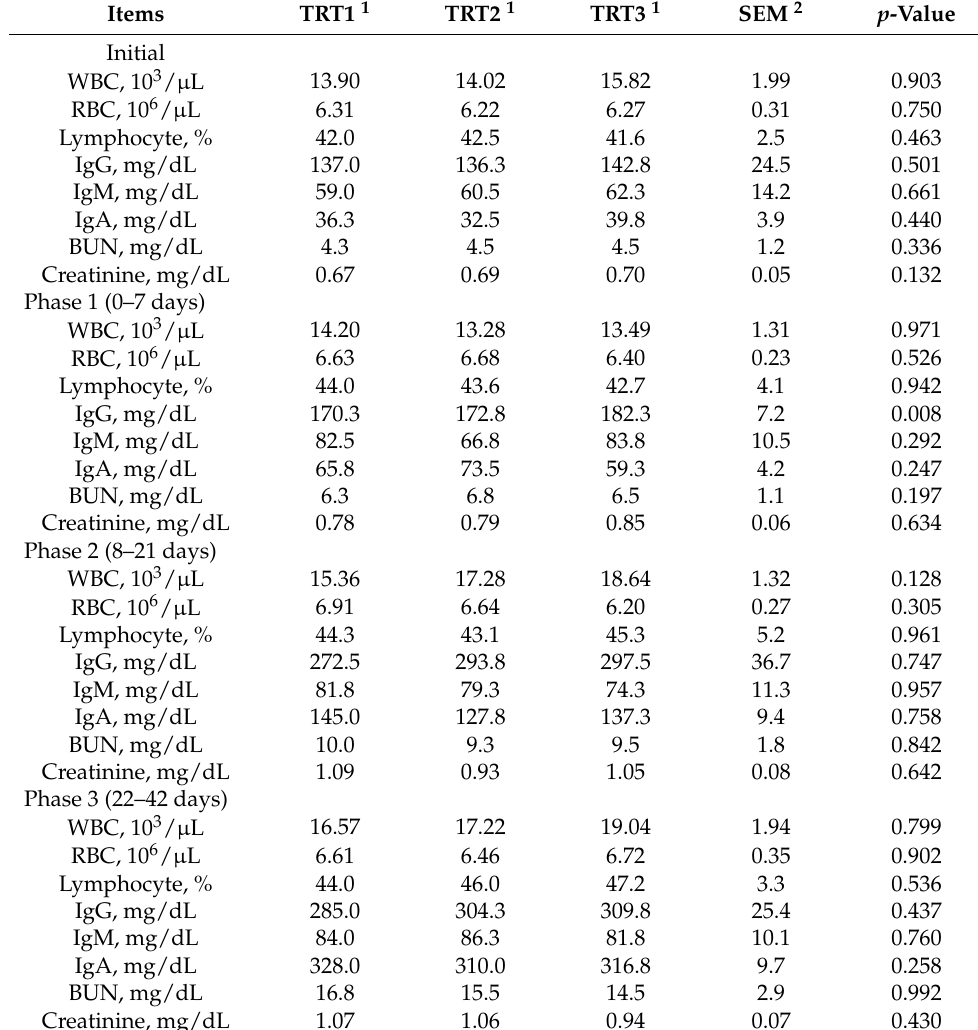
Table 7. Effect of blood plasma and yeast supplementation on the blood profile of weaning pigs 1